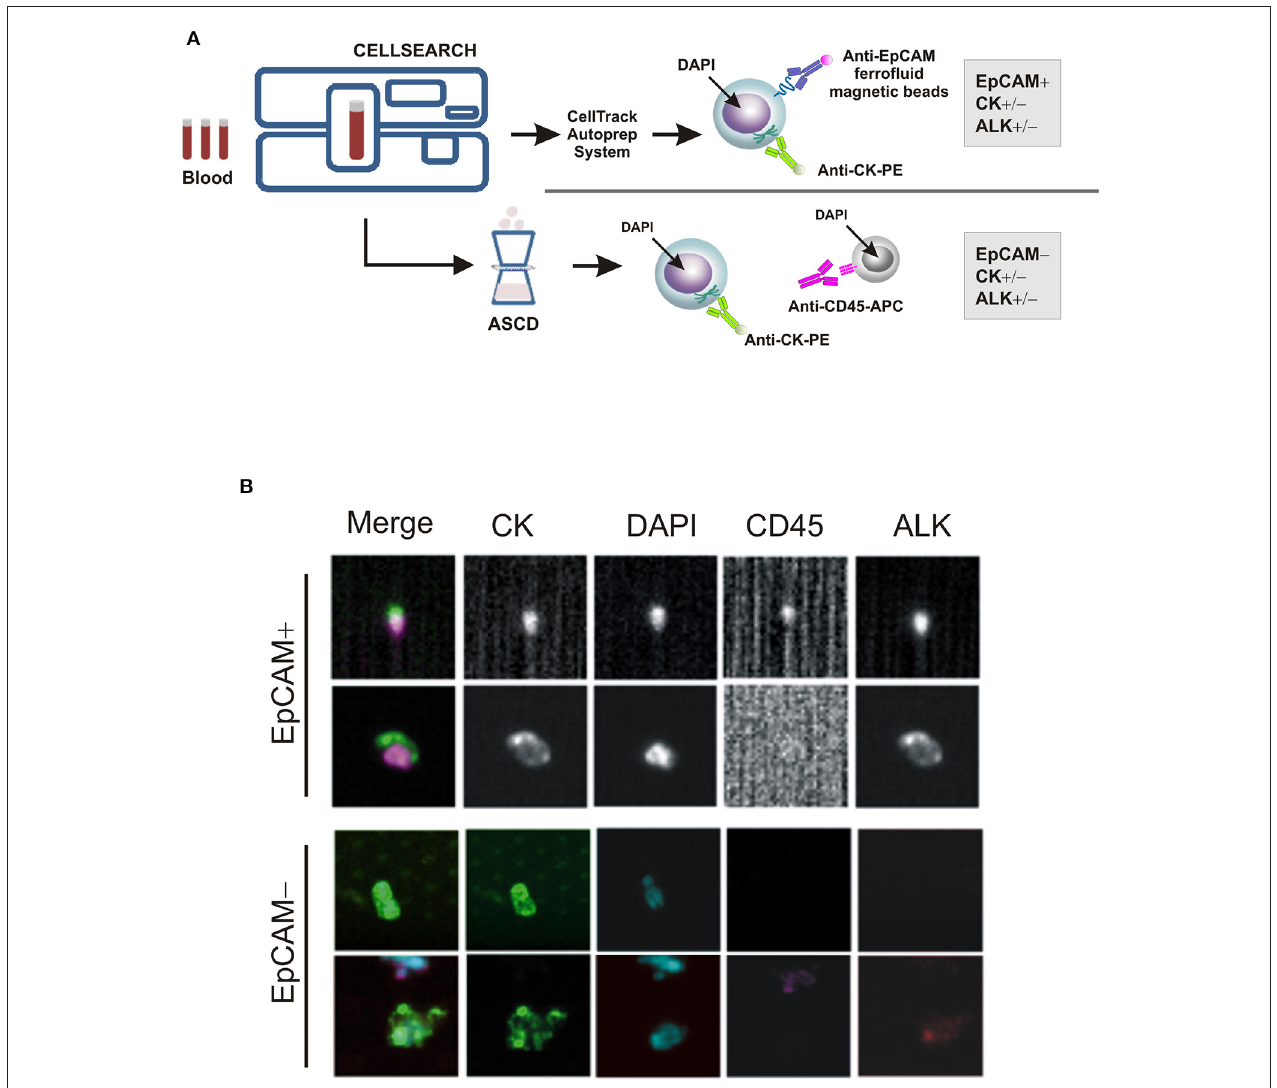
FIGURE 2 | CTC enrichment and detection. (A) The CTC enrichment approach used to detect and isolate EpCAM-positive (EpCAM high / + ) and negative (EpCAM low / − ) CTCs from cancer patients’ blood samples by the CellSearch system and the ASCD device, respectively. APC-tagged anti-CD45 antibody is used to detect and distinguish peripheral blood leukocytes from CTCs, whereas ferrofluid-tagged and PE-tagged anti-EpCAM and -CK antibodies to isolate EpCAM + /CD45 − and/or CK + /CD45 − cells, respectively. (B) Representative images of EpCAM + and EpCAM − CTCs captured by CellSearch and ASCD, and stained for cytokeratins (CK), CD45, ALK or with nuclear dye